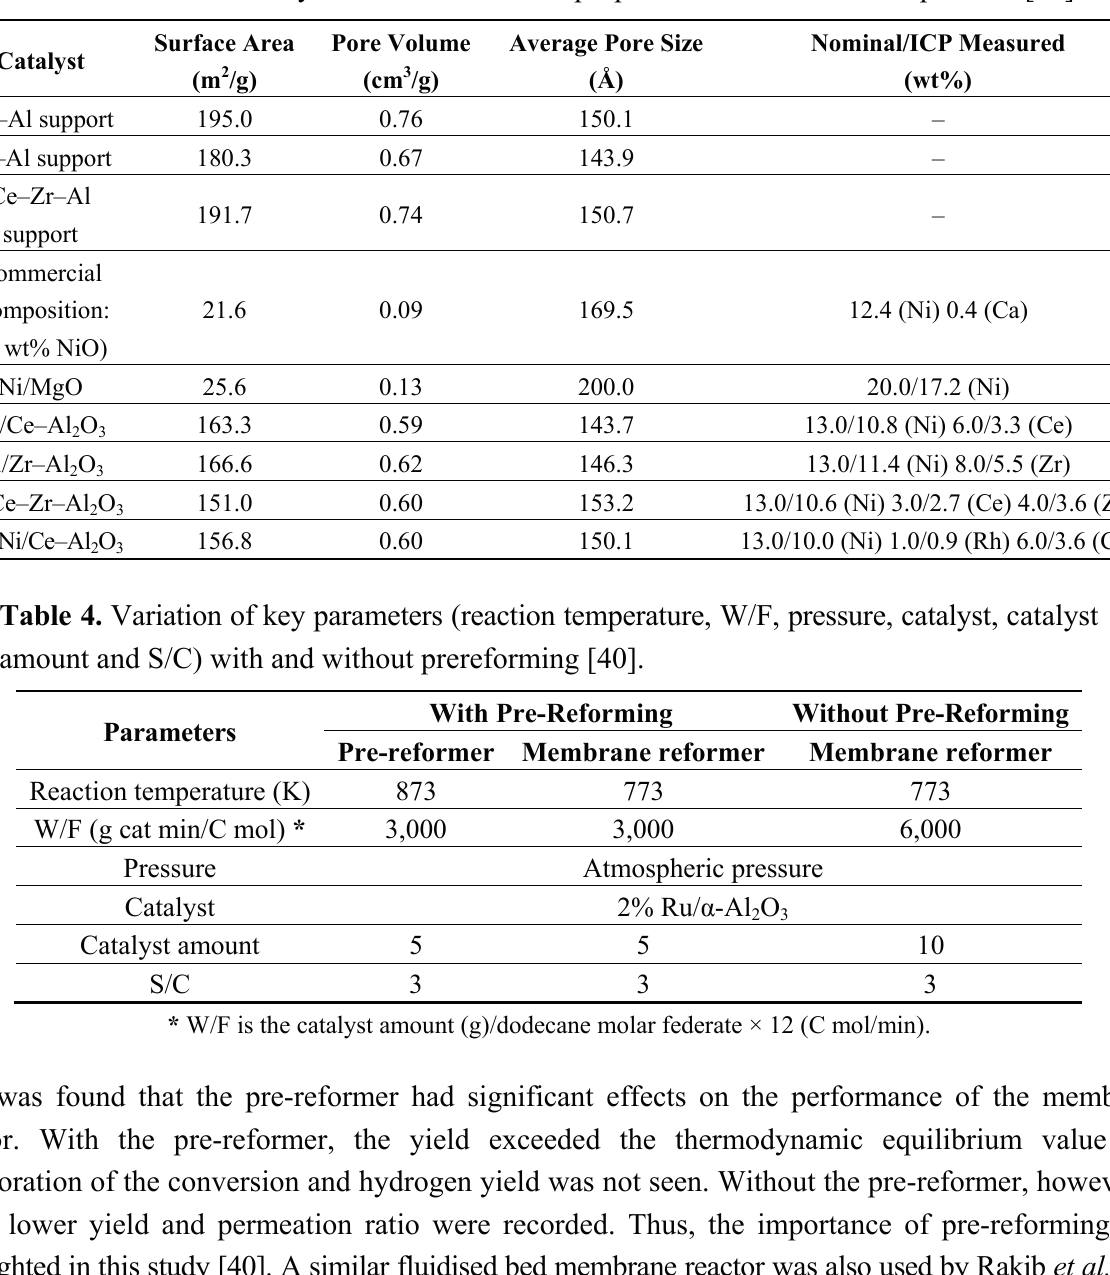
Table 3. Calcined catalysts used with textural properties and chemical composition [39].